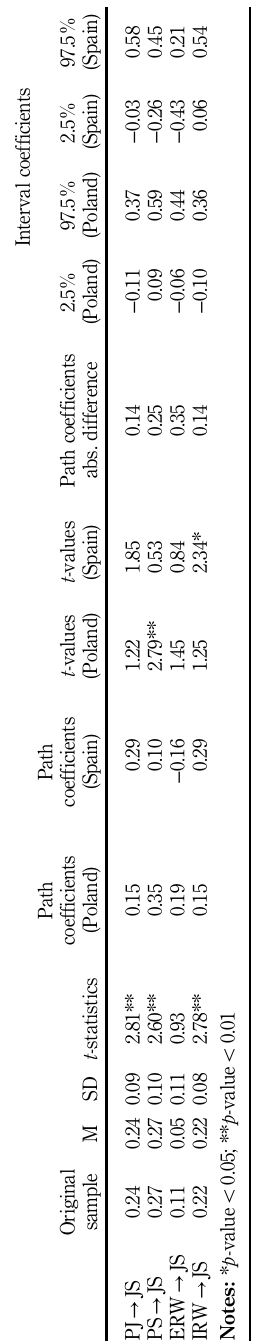
Table IV. Path coefficients and PLS-MGA results: Country effect (Bootstrapping 5000